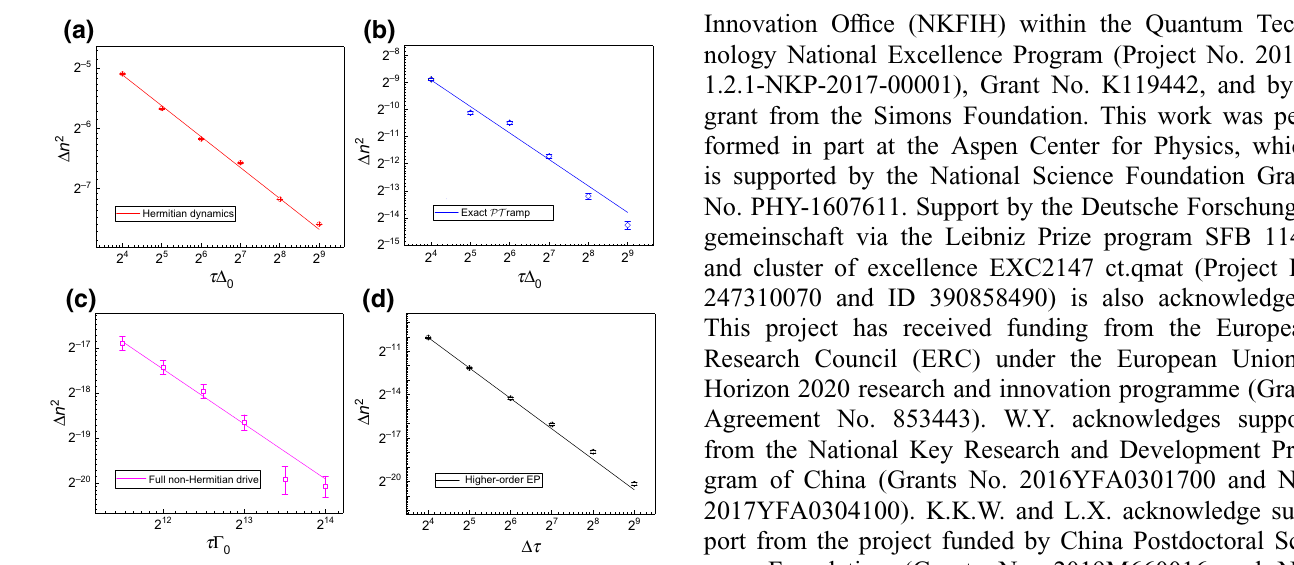
FIG. 5. The fluctuations of the defect production for different parametric ramps. The variance in the total defect densities (a) of the Hermitian case, (b) of the exact PT case, (c) across the non- Hermitian, second-order EPs, and (d) across a fourth-order EP, respectively, as functions of the ramp time τ . The solid lines rep- resent the results for the power-law fits (cid:3) n 2 ∼ τ α to the exper- imental data, with the fitted exponents (a) α = − 0.512 ( 2 ) , (b) α = − 0.97 ( 3 ) , (c) α = − 1.2 ( 1 ) , and (d) α = − 2.11 ( 4 ) , which correspond to the theoretical predictions (a) α = − 1 / 2, (b) α = − 1, (c) α = − 4 / 3, and (d) α = − 2,